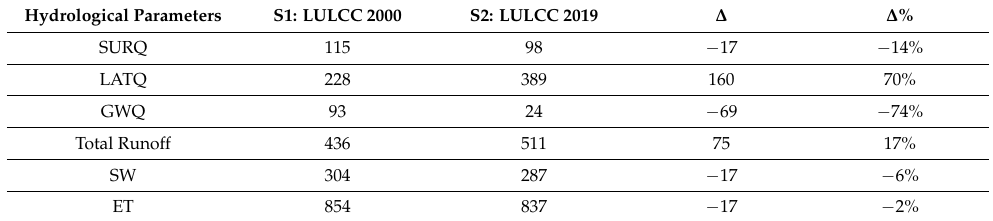
Table 11. Land Use Change from 2000 to 2019.